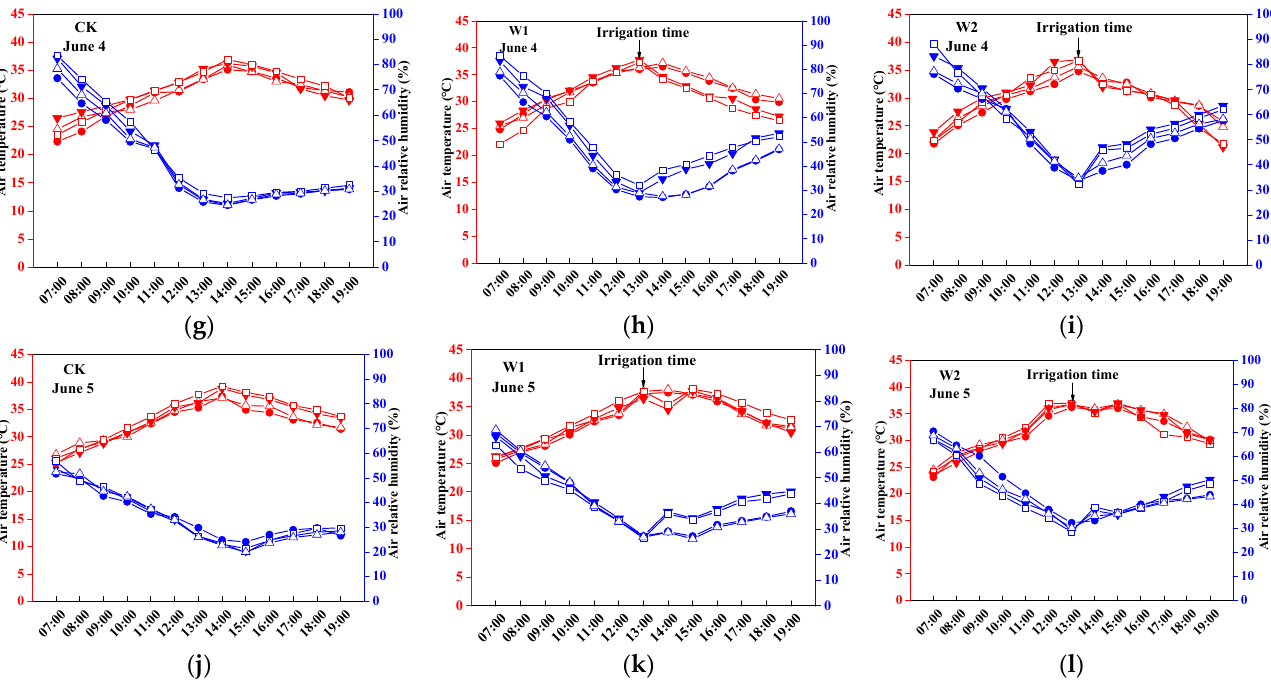
Figure 4. Time course of air temperature and air relative humidity with ( a ) CK, ( b ) W1, ( c ) W2 treatments on 27 May, ( d ) CK, ( e ) W1, ( f ) W2 treatments on 1 June, ( g ) CK, ( h ) W1, ( i ) W2 treatments on 4 June, and ( j ) CK, ( k ) W1, ( l ) W2 treatments on 5 June when dry-hot wind occurred in 2018, respectively. W1, W2, and CK represent 2.5 mm, 5 mm, and no irrigation treatments during dry-hot wind condition, respectively.